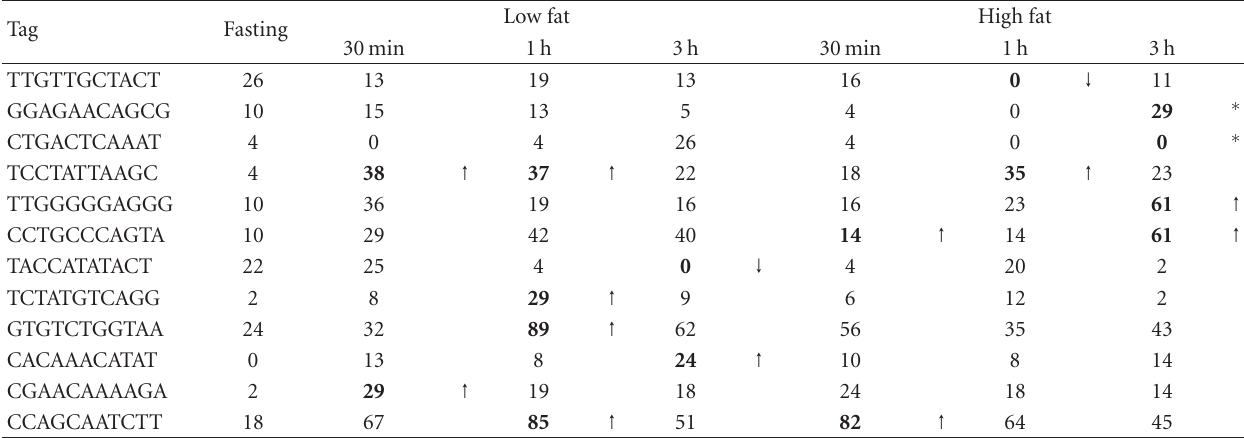
Table 3: Novel transcripts di ff erentially modulated by feeding in the gastric mucosa. Tag